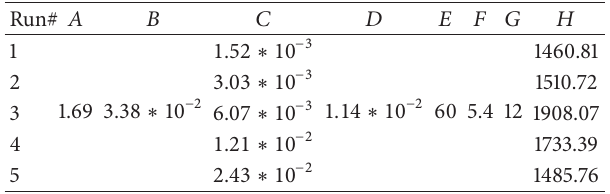
Table 2: Reactions conditions with different initiator concentra-